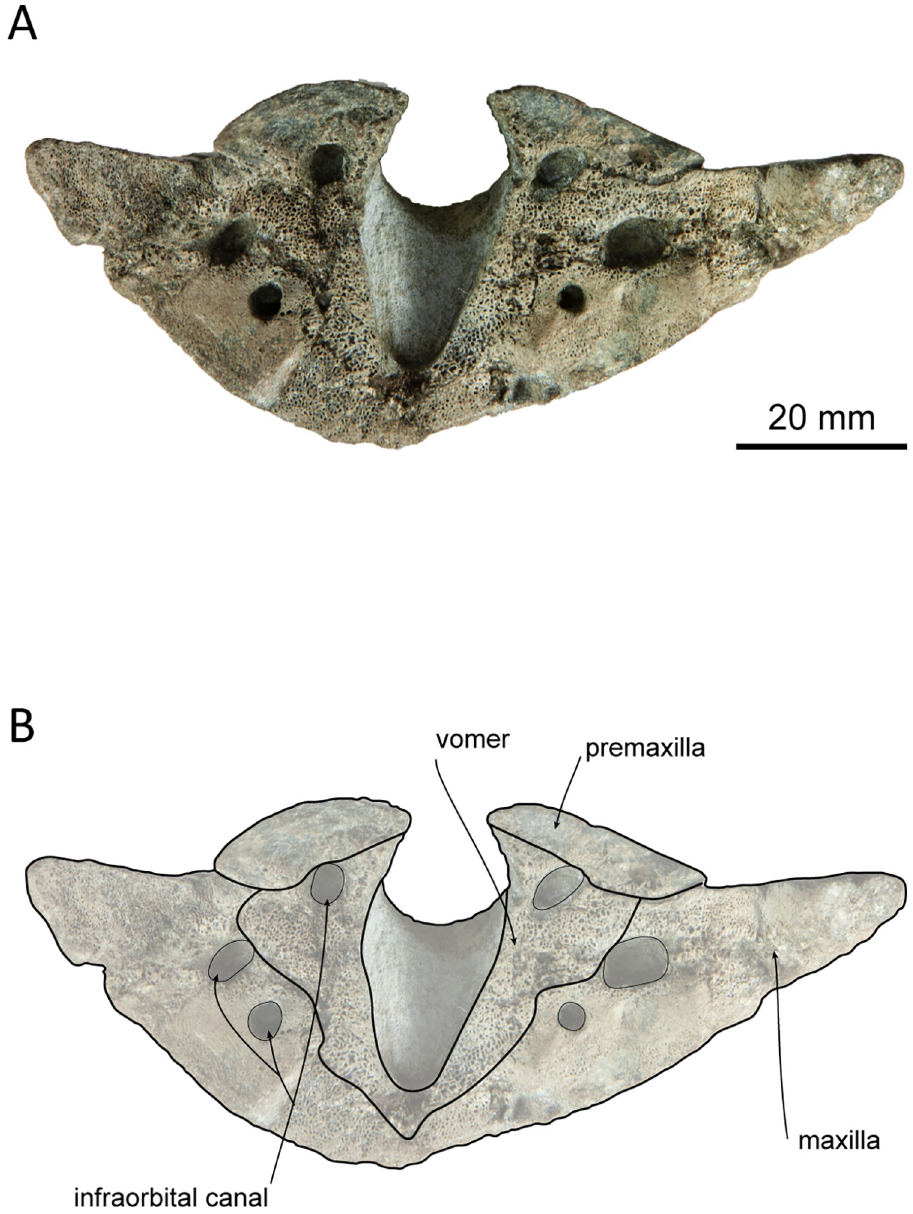
Fig 6. Posterior view of the cross section of rostrum Platysvercus ugonis gen. et sp. nov., holotype, UTHFM 00034, 50 mm anterior to the antorbital notch. (A) photo. (B) corresponding line drawing with anatomical interpretations. Scale bar equals 20